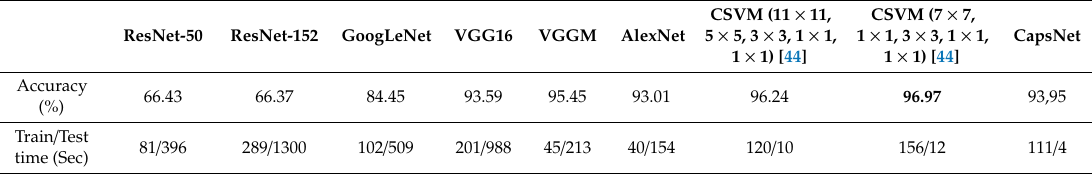
Table 11. Comparison with the state-of-the-art on the Solar Panel